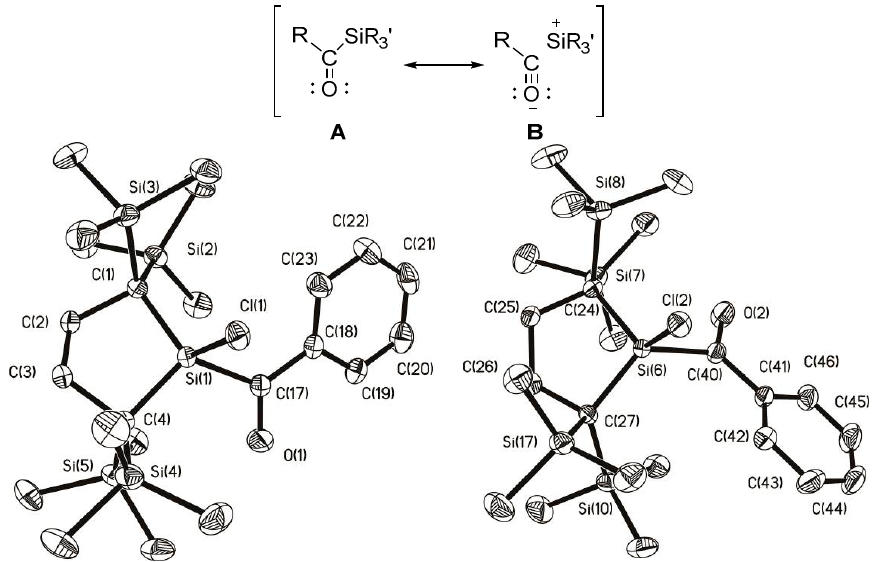
Figure 1. ORTEP drawing of the independent molecules in 3a . (Hydrogen atoms are omitted for clarity. Thermal ellipsoids are shown at the 30% probability level.) Selected bond lengths (Å) and angles (°): Si(1)–C(4) 1.877(2), Si(1)–C(1) 1.890(2), Si(1)–C(17) 1.935(3), Si(1)–Cl(1) 2.1006(9), O(1)–C(17)